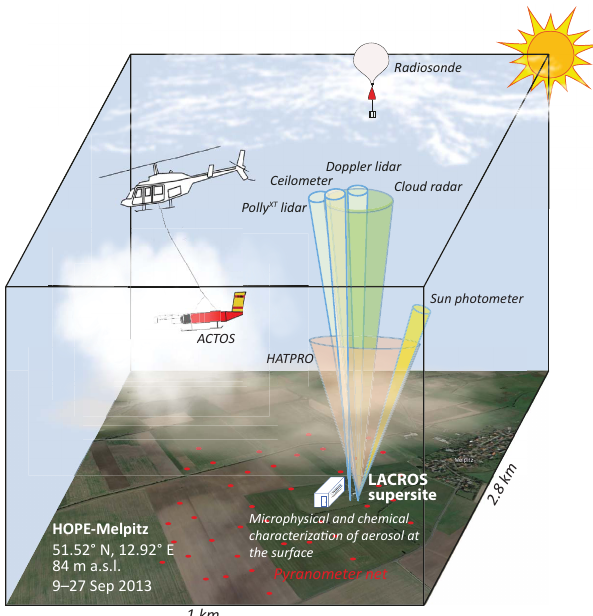
Figure 2. Illustration of the set-up of the HOPE-Melpitz campaign showing the deployed main instrumentation. The cones illustrate the field of view of the specific remote-sensing